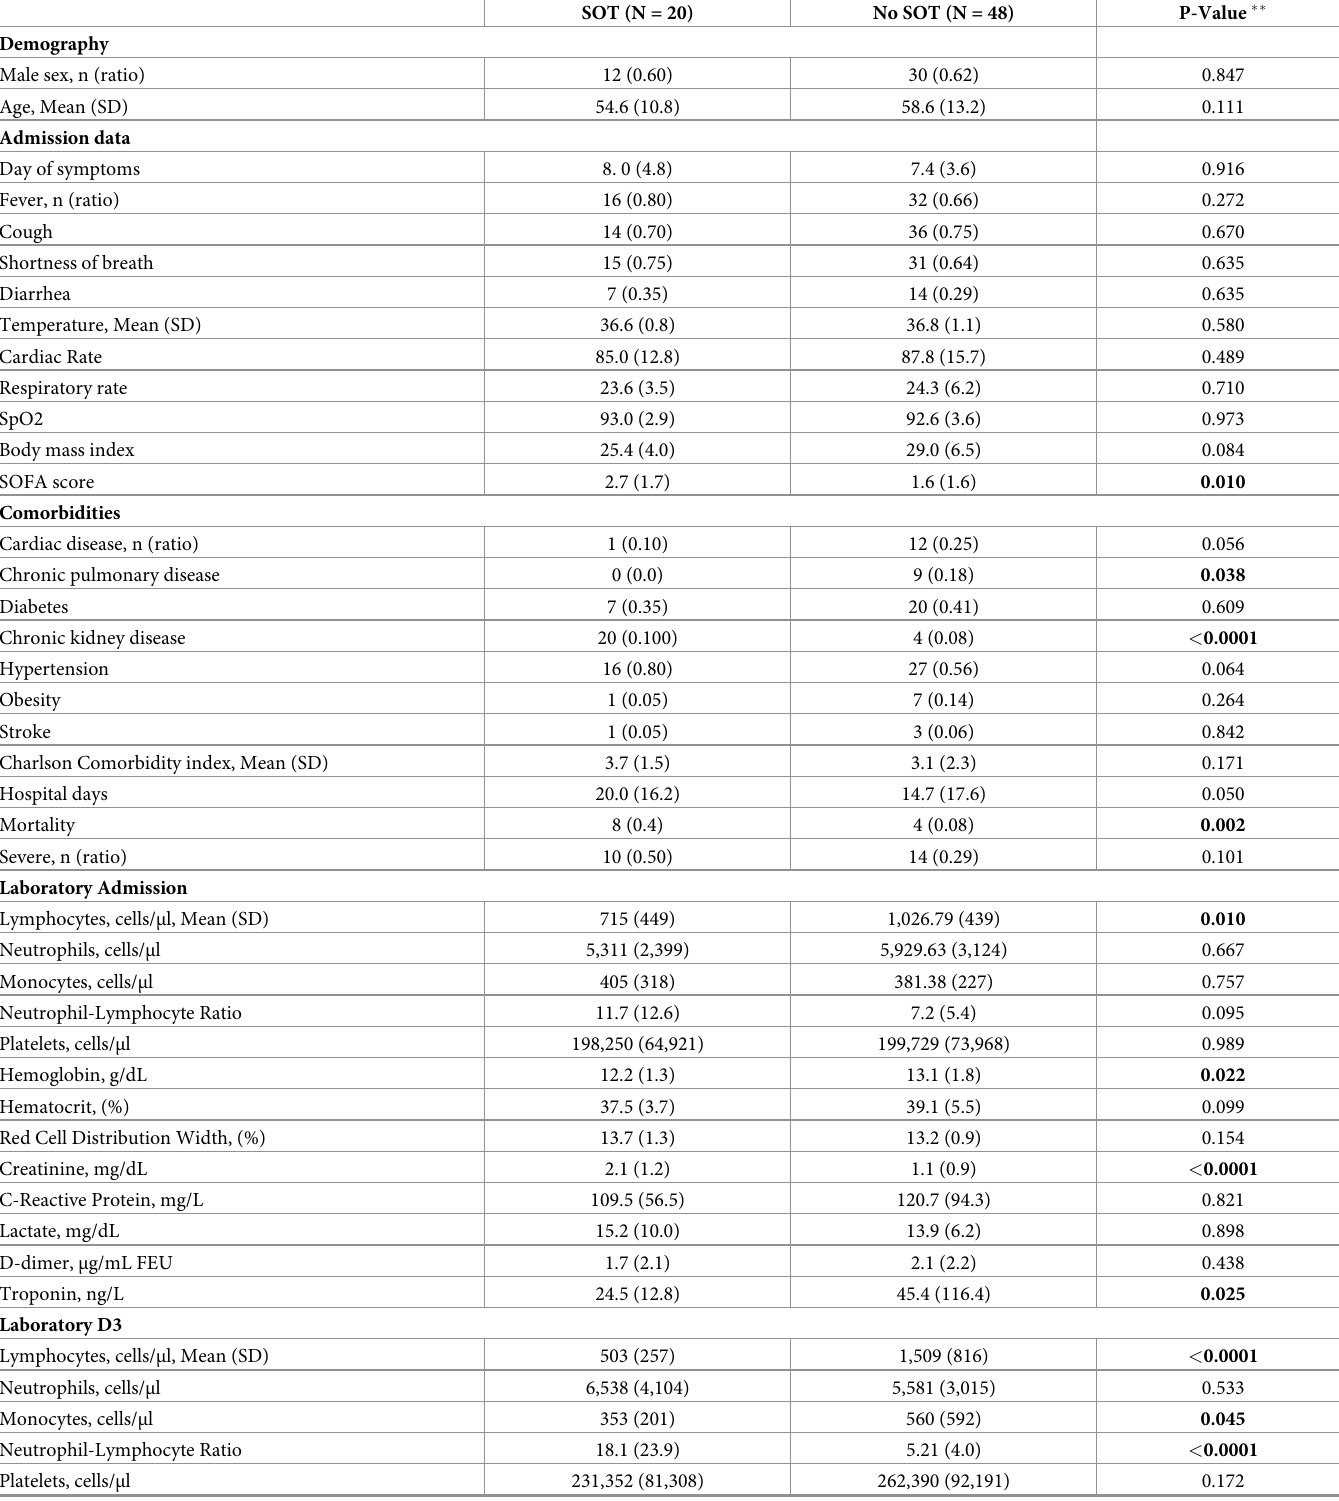
Table 2. Epidemiologic and clinical characteristics, and routine laboratory tests of KT recipients and non-KT recipients COVID-19